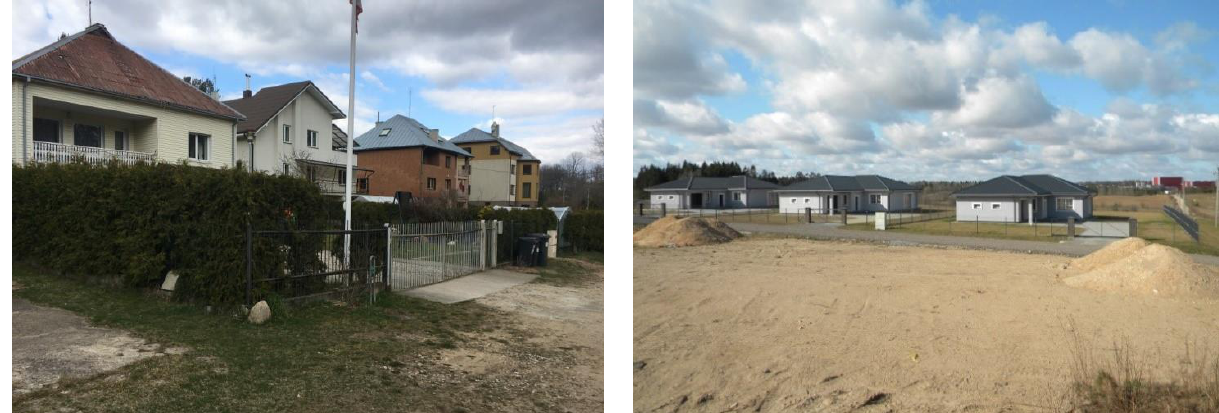
Fig. 6. Transformation of the collective gardens into residential neighbourhoods (Source: authors)